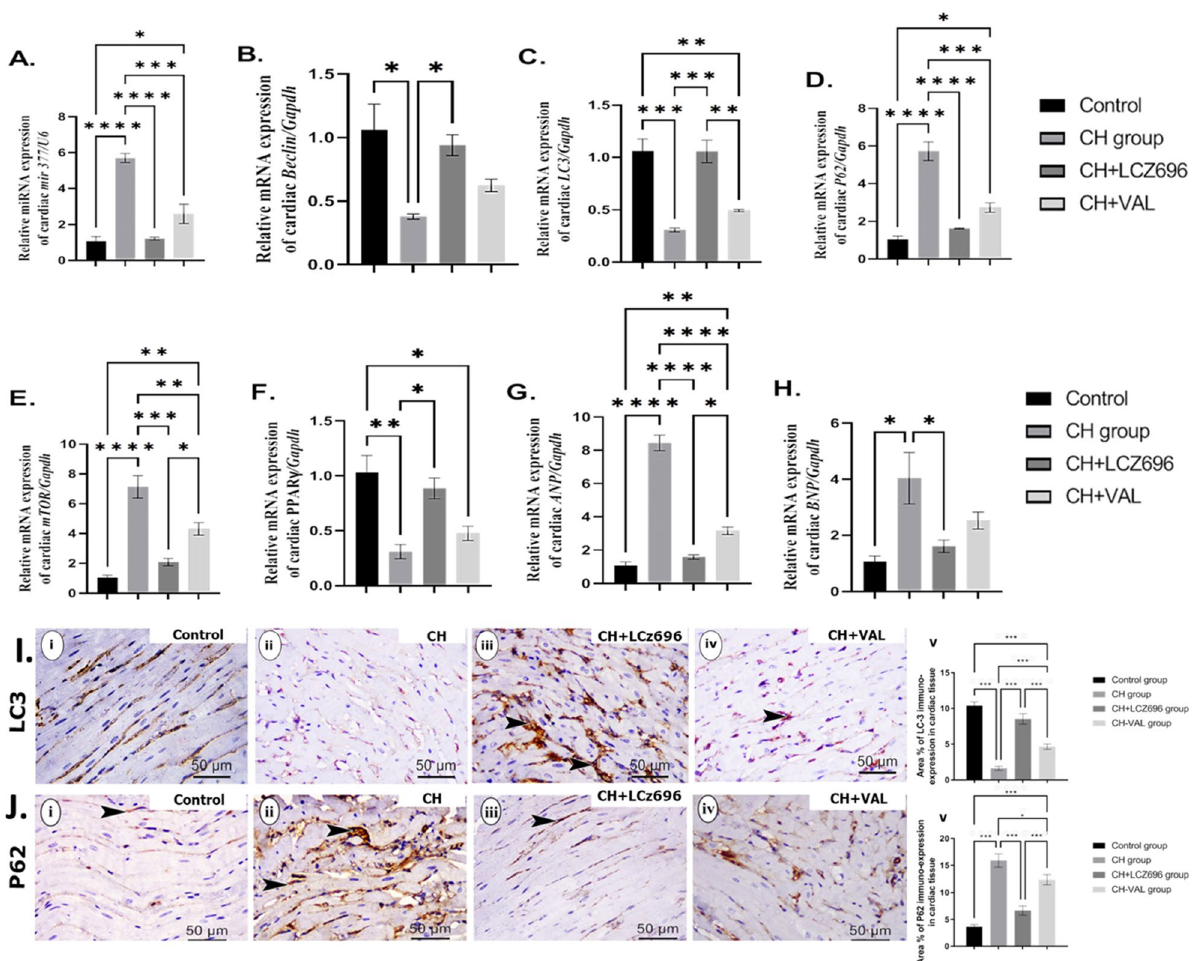
Figure 3. The effect of the LCZ696 and VAL administration on the expression of the cardiac autophagy, natriuretic-peptide, and their regulatory miRNA ( A – J ). ( A ) relative miRNA expression of cardiac mir-377/U6 (%control), ( B ) relative mRNA expression of cardiac Beclin/Gapdh (%control), ( C ) relative mRNA expression of cardiac LC-3/Gapdh (%control), ( D ) relative mRNA expression of cardiac P62/Gapdh (%control), ( E ) relative mRNA expression of cardiac mTOR/Gapdh (%control), ( F ) relative mRNA expression of cardiac PPAR- ϒ /Gapdh (%control), ( G ) relative mRNA expression of cardiac ANP/Gapdh (%control), ( H ) relative mRNA expression of cardiac BNP/Gapdh (%control), ( I ) (i–v) representative photomicrographs showing the estimation of immunohistochemical staining of LC-3 in rat cardiac tissues of the different experimental groups (i) Control group, (ii) CH group, (iii) CH + LCZ696 group, (iv) CH + VAL group, and (v) a bar chart demonstrates the changes in the area % of LC-3 immune-positive cells of the different experimental groups, and ( J ) (i–v) representative photomicrographs showing the estimation of immunohistochemical staining of P62 in rat cardiac tissues of the different experimental groups (i) Control group, (ii) CH group, (iii) CH + LCZ696 group, (iv) CH + VAL group, and (v) a bar chart demonstrates the changes in the area % of P62 immune-positive cells of the different experimental groups. Values are mean of 6 rats per group ± S.E.M * p < 0.05; ** p < 0.01; and *** p < 0.001. . Group means were compared by one-way analysis of variance (ANOVA) followed by Tukey post hoc tests for multiple